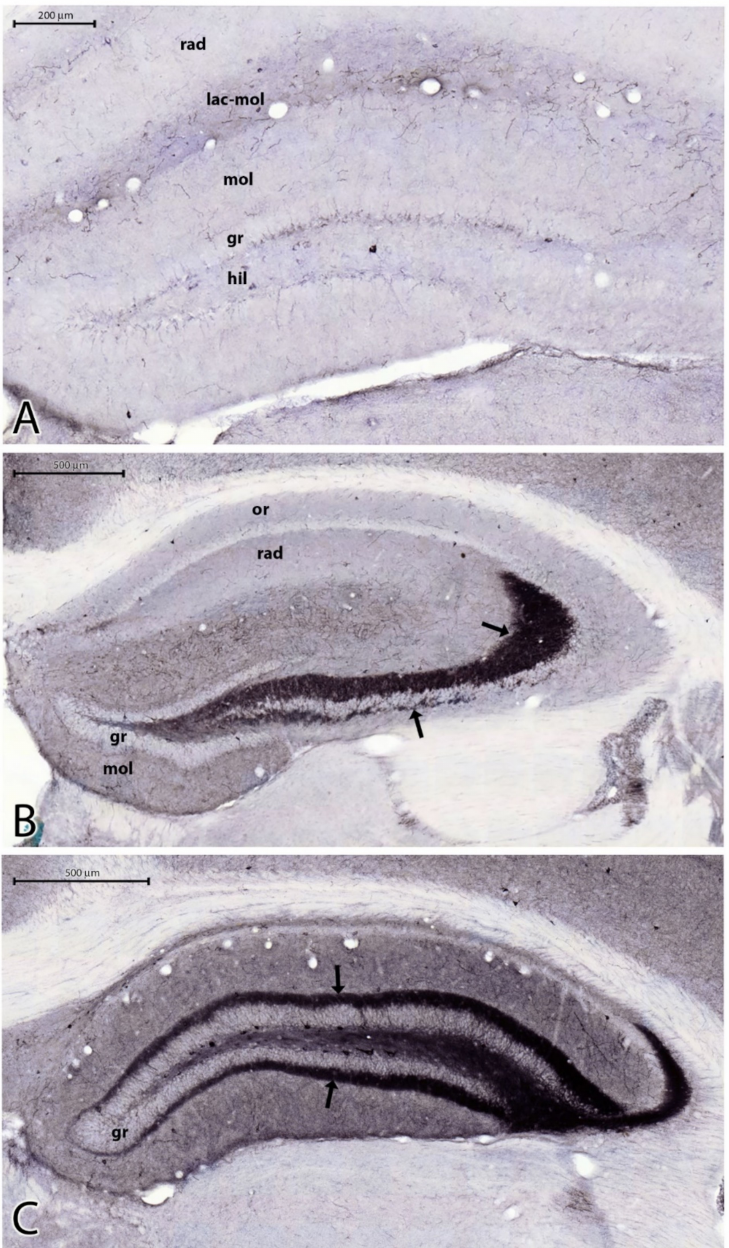
Figure 4. NPY immunostaining of control ( A ) and epileptic ( B , C ) hippocampi. ( B ) PT5 animal. ( C ) PT3 animal. Black staining indicates sprouting NPY-containing axons in the hilum, in stratum lucidum, and stratum oriens of CA3 (( B ), arrows). The IML of the DG was also heavily infiltrated by sprouting axons (( C ), arrows). Abbreviations: rad = stratum radiatum; lac-mol = stratum lacunosum- moleculare; mol = molecular layer of DG; gr = granular layer of DG; hil = hilum of DG. Bars: ( A ) 200 µ m; ( B , C ) 500 µ